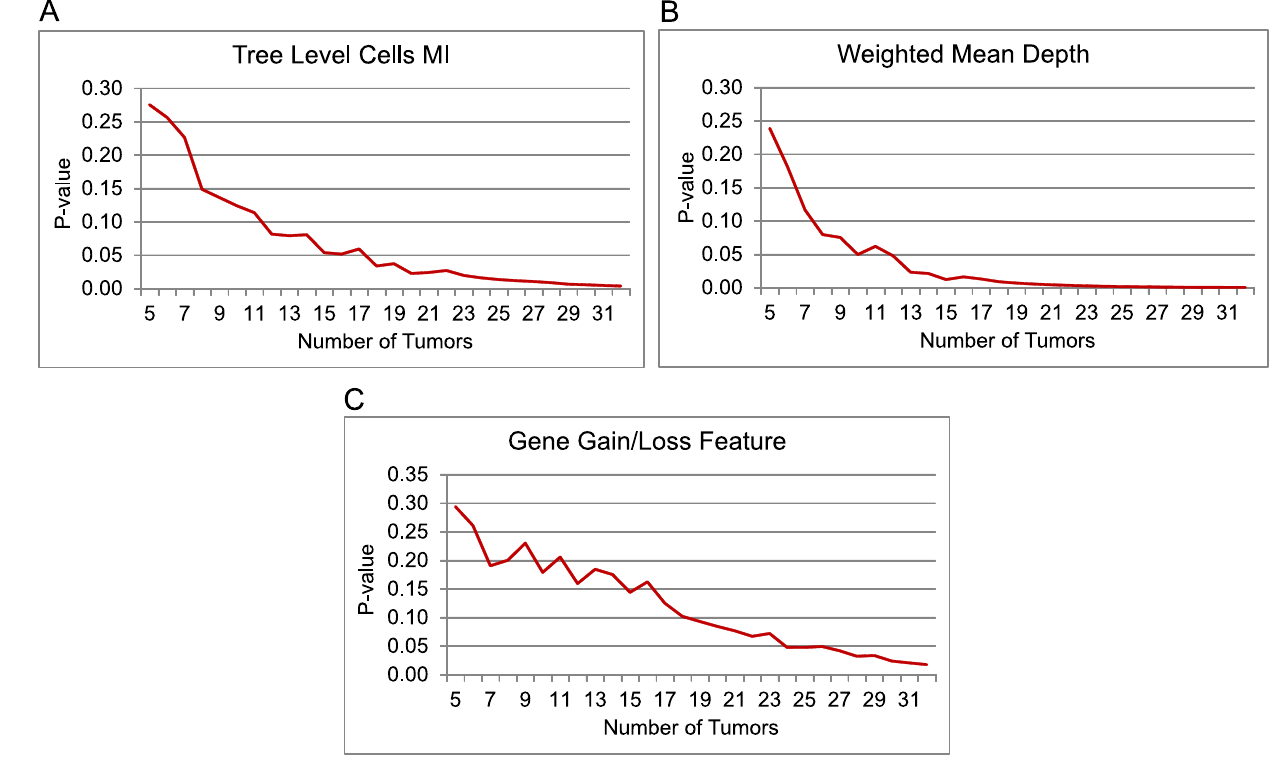
Figure 9. Wilcoxon signed rank test results for separating primary CC samples from the metastases. Wilcoxon signed rank test 1-sided p-values for separating the primary CC samples from the metastases across subsets of increasing numbers of randomly selected tumor samples. For each set of i tumors, i samples were randomly selected from 32 paired CC primary and metastatic tumors with atleast one of each type and then Wilcoxon signed rank test was used to calculate the p-values for separating the primary from metastases based on three different statistics: (A) Shannon index calculated using the distribution of cells across different tree levels, (B) weighted mean depth of the trees and (C) sum of differences of fractional gain and loss of each gene across the tree edges.